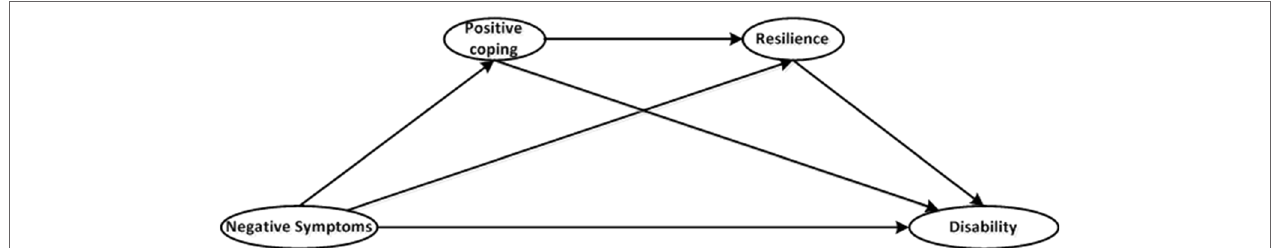
FIGURE 1 | Proposed schizophrenia disability distal mediation